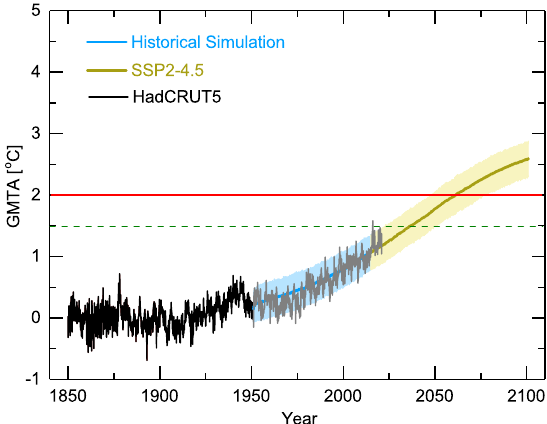
Fig. 3 GMTA simulation and projection based on the FISM-based response model. Using the linear (nearly proportional) relations as shown in Eq. (2), the trend of the direct-forcing-response from 1951 to 2014 is calculated from the historical anthropogenic ERF data, and the trend of the direct-forcing-response from 2015 to 2100 is estimated from SSP2-4.5 data. The simulated historical GMTAs are shown in blue color, where the blue area indicates the 95% boundaries of 1000 realizations and the thicker blue line represents the mean simulation. The projected future GMTAs are shown in yellow color. The black curve represents the HadCRUT5 GMTA. It is worth noting that the simulation and projection are made by considering the climate memory impacts from the past 100 years, i.e., for the simulation of GMTA in 2001, climate memory impacts from 1901 to 2000 are taken into account.